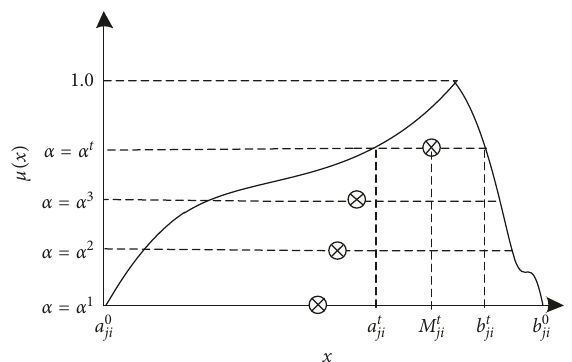
Figure 1: The level rank method of